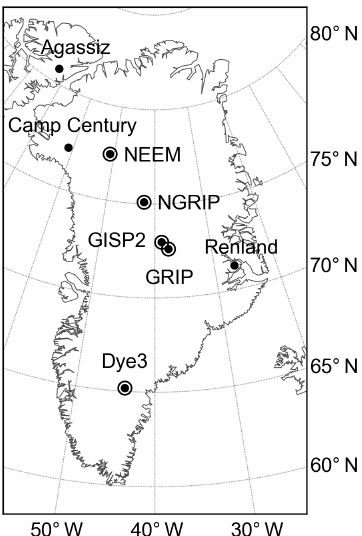
Figure 1. Locations of the ice-core sites referenced in this study. We use oxygen isotope ( δ 18 O) records from all eight sites and ac- cumulation records from the five circled